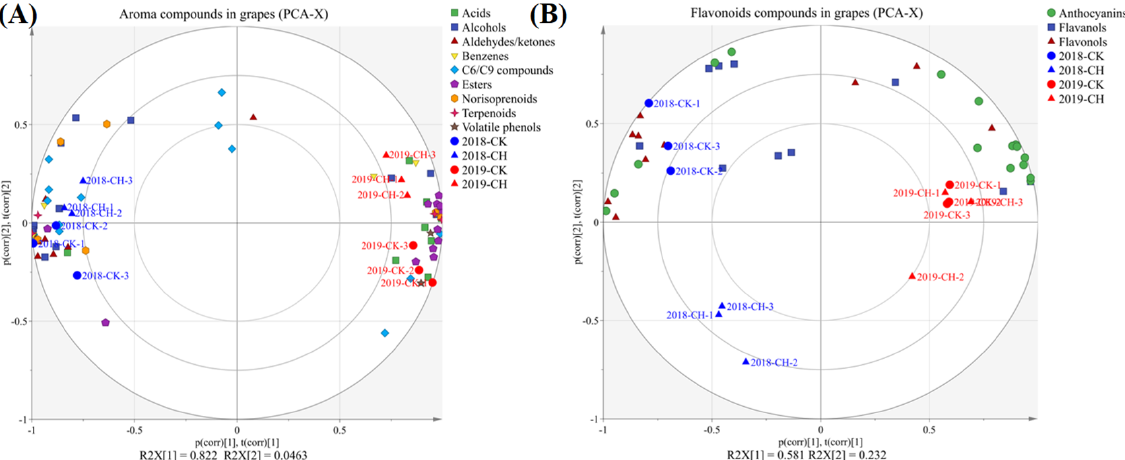
Figure 3. PCA based on aroma and flavonoids compounds concentrations separating grape samples according to vintage and treatment. ( A ) correlation loading plot in aroma compounds of grape berries, ( B ) correlation loading plot in flavonoids in grape berries.